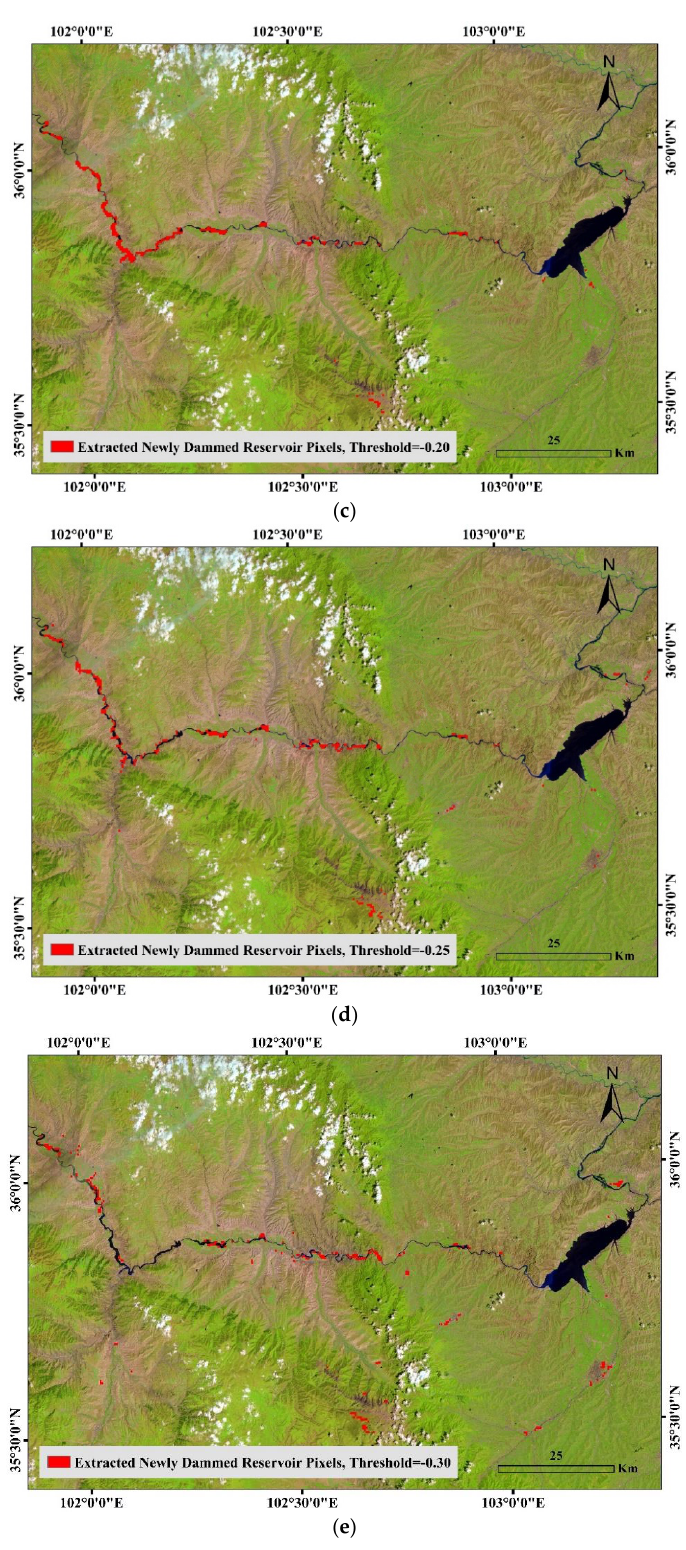
Figure 12. Extracted newly dammed reservoir pixels when value of threshold was set to −0.10 ( a ), −0.15 ( b ), −0.20 ( c ), −0.25 ( d ), and −0.30 ( e ).